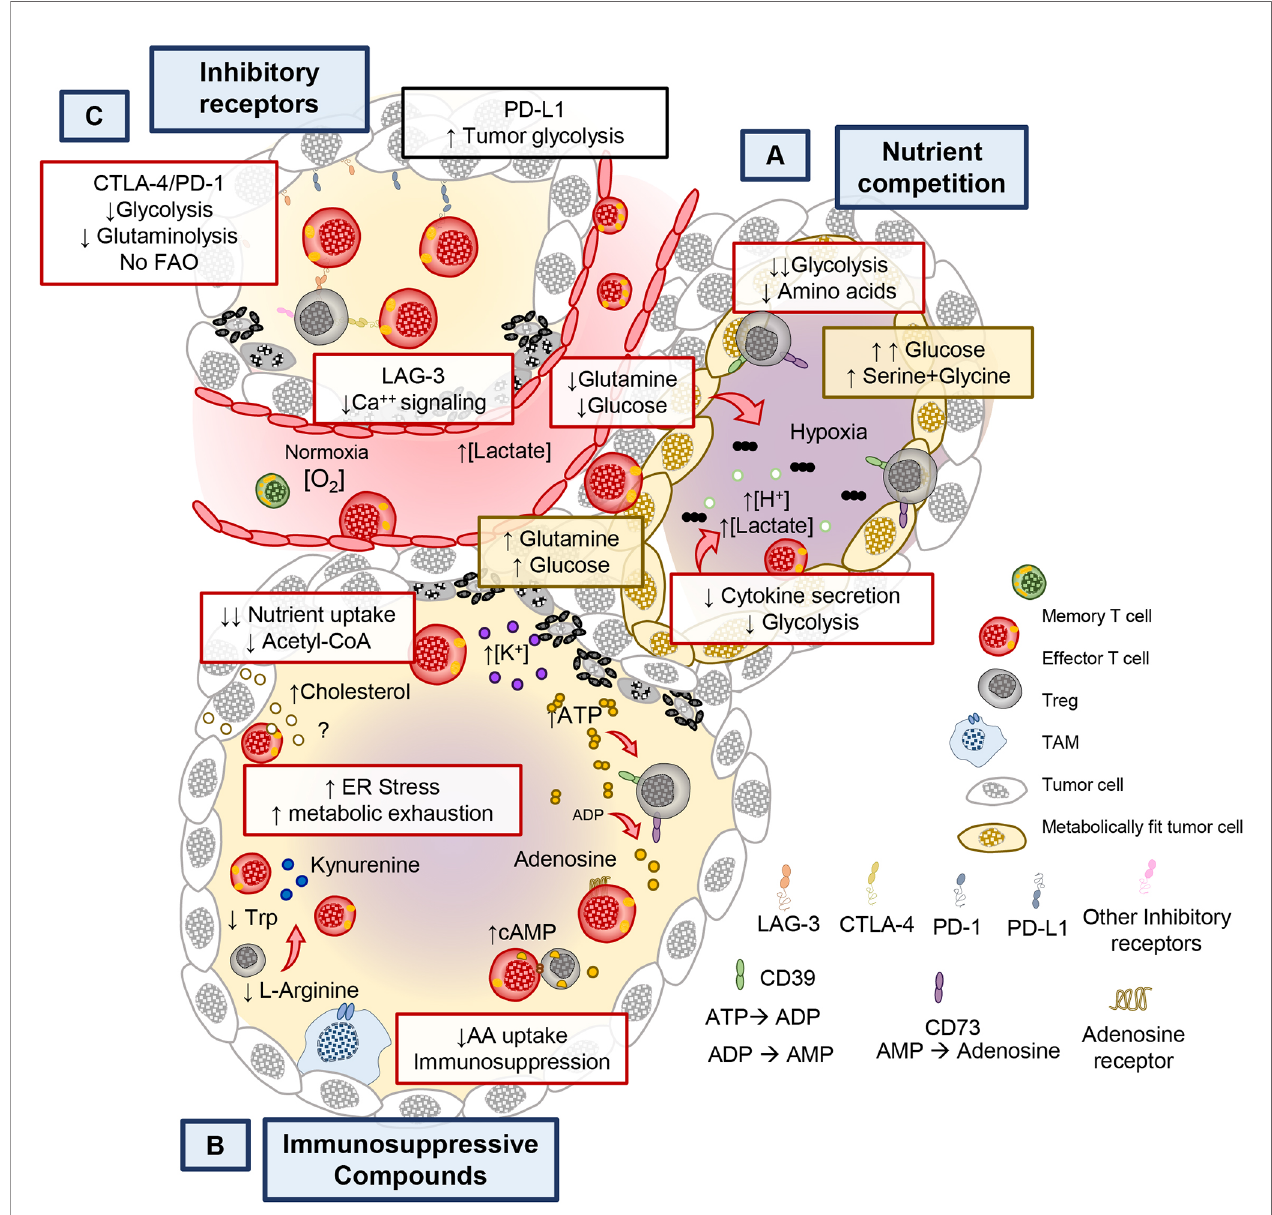
FIGURE 3 | Metabolic and immunological checkpoints that hinder T cell mediated tumor immunity. (A) Tumors can adapt their metabolism in response to nutritional stress to better compete and scavenge for glucose and amino acids to suppress T cell bioenergetics. (B) Chronic stimulation in the tumor bed leads to the expression of immune checkpoint receptors such as PD-1/PD-L1, CTLA-4, LAG-3, and they exert negative metabolic functions in T cells. (C) Furthermore, Ionic imbalances, oxygen availability, and metabolites impact the function of T cells. By products of immunosuppressive immune cells, cell debris and tumor metabolites create the conditions that contribute to the metabolic exhaustion of tumor speci fi c T